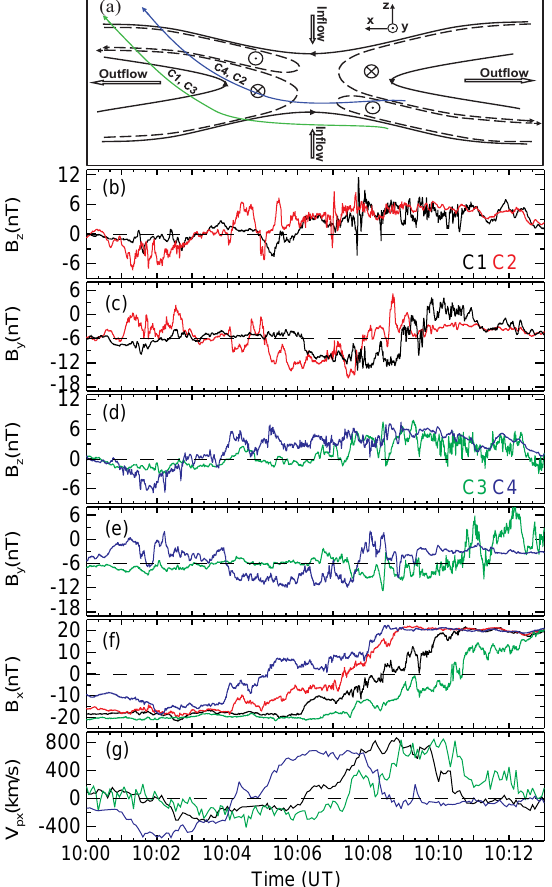
Fig. 1. Overview of the reconnection event in the magnetotail from 10:00 to 10:13UT on 28 August 2002 is shown. From top to bottom, (a) an schematic illustrator of the ion diffusion region, (b) magnetic field component B z at C1 (black line) and C2 (red line), (c) B y at C1 and C2, (d) B z at C3 (green line) and C4 (blue line), (e) B y at C3 and C4, (f) B x from all four satellites, and (g) x component of proton bulk flows V p x from C1, C3, and C4 are